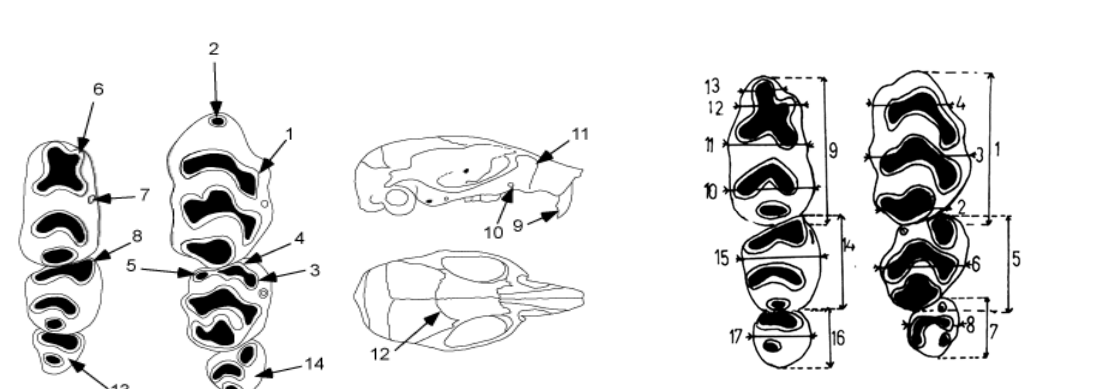
F IG . 2. - List of characters and character states used in analyses. States are given in brackets. Polarity of character states is discussed in the text. (*) according to Jacobs’ (1978); (**) to Miller’s (1912); (** *) Michaux’s (1971) (Darvish 1988, 1997).